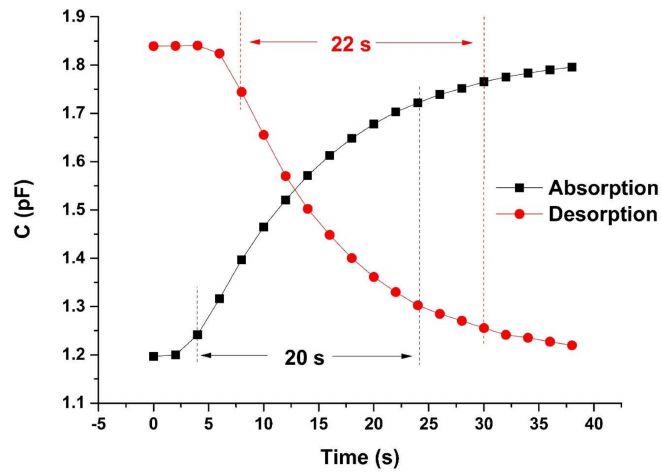
Figure 9. The response and recovery curves are measured by switching the SIDE sensor, alternately, between 2.0% ± 0.8% and 77.0% ± 0.8% RH. The response/recovery time is 20 s/22 s.